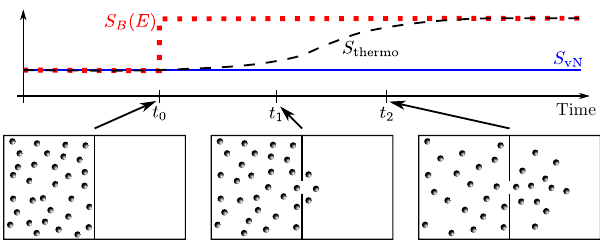
FIG. 3. Thought experiment with a gas in a box with perfectly reflecting boundaries. Initially, the gas is confined to the left half of the box. Then, at t 0 a small hole is opened in the wall such that gas particles can diffuse to the right. Since the gas needs time to diffuse, it seems sensible to demand that thermodynamic entropy should smoothly interpolate between the lower initial and higher final value (dashed line). In contrast to this desideratum, von Neumann entropy stays constant for all times (thick blue line). A naive application of Boltzmann’s entropy S B ( E ) captures the correct initial and final value, but contains a sudden discontinu- ous jump at t 0 even if the hole in the wall is very small. Thus, it misses some relevant dynamical information. For a similar and more detailed discussion see Ref.